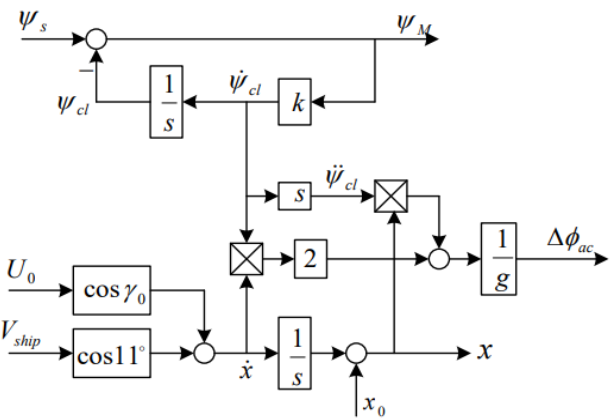
Figure 31. The rolling compensation instruction model for lateral deck motion.